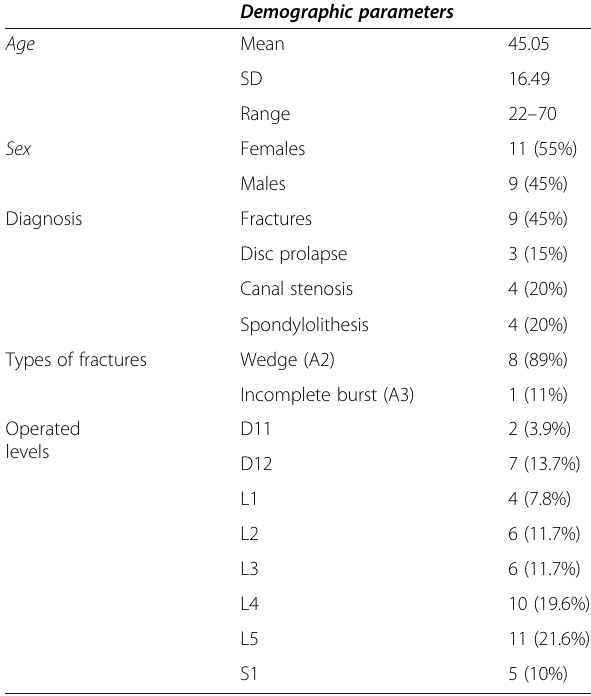
Table 1 Demographic, clinical, and pathological properties of the included patients in our study Demographic